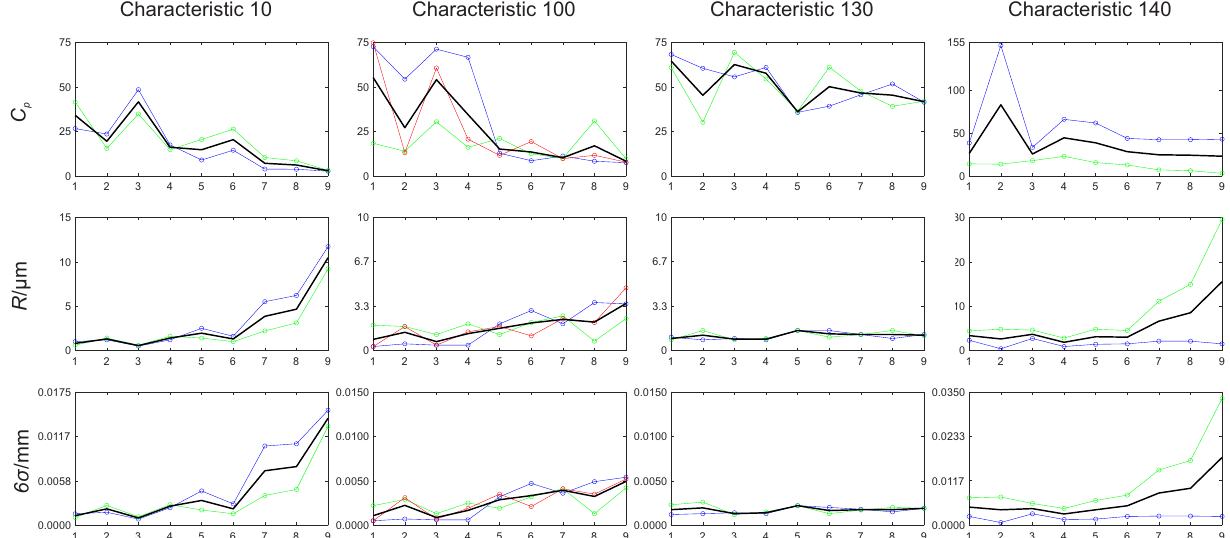
Figure 10. Measurement results for PKR object characteristic code 10 (height), code 100 (height), code 130 (diameter), and code 140 (height). Red, green, and blue lines represent individual measurements, while black lines represent the average measurement values. The absolute value of statistical parameters ( C p , R , and 6 σ ) is not as significant as the decreasing/increasing trend. Scenario numbers appear on the horizontal